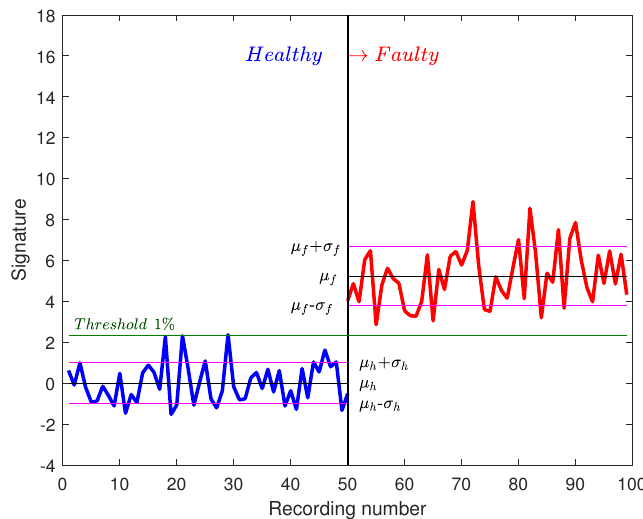
Figure 14. Fault signatures using 1 cycle with 50 recordings.